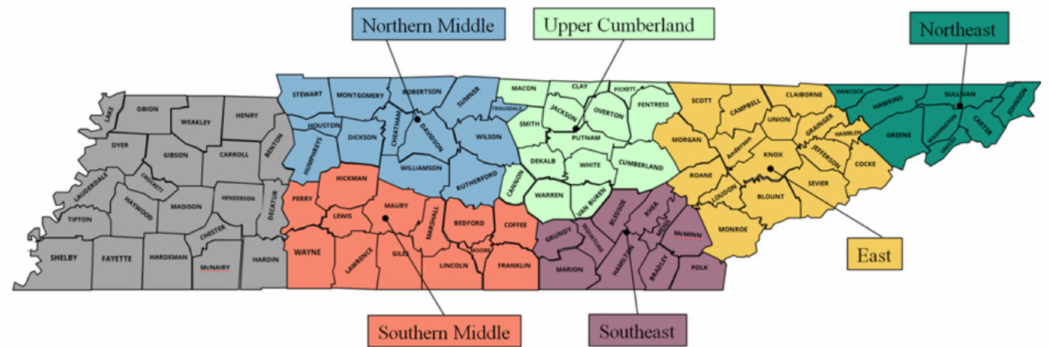
Figure A2. This Map from the Tennessee State Government shows the Counties in Tennessee including the showing the eight northeastern Counties where PHIP project was